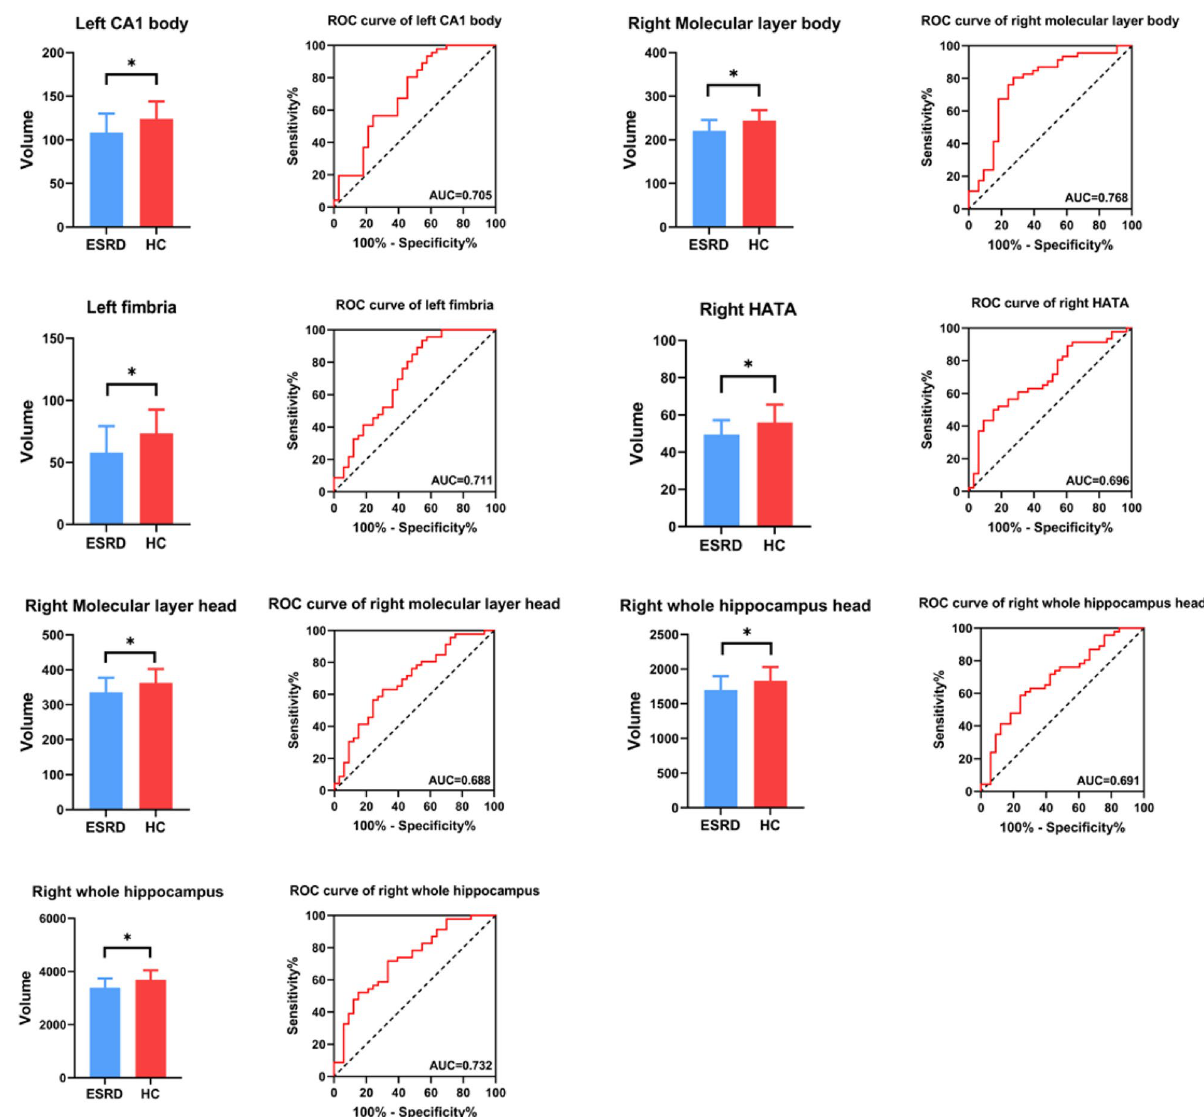
Figure 2. Volumes of the whole hippocampus and subfields showed significant group difference in ESRD and HCs. *represents the statistical difference between the two groups, correction adjusted p value ( q value) < 0.05. ROC curves analysis based on the left CA1 body, left fimbria, right molecular layer head, right molecular layer body, right HATA, right whole hippocampal head and right whole hippocampal volumes. CA cornus ammonis, HATA hippocampus-amygdala transitional area.